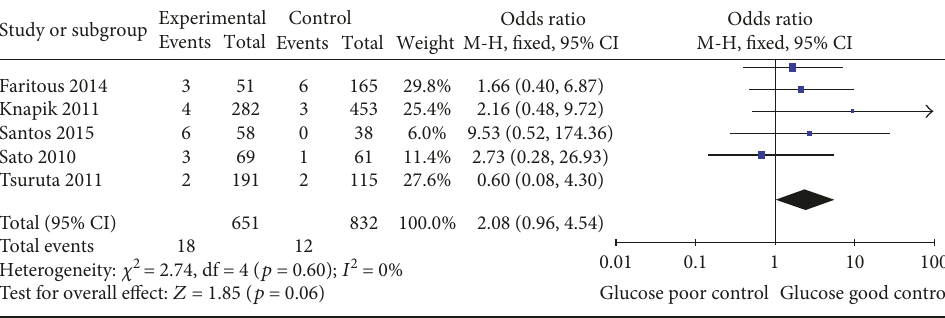
Figure 5: Forest plot of the relationship between HbA1c level and renal